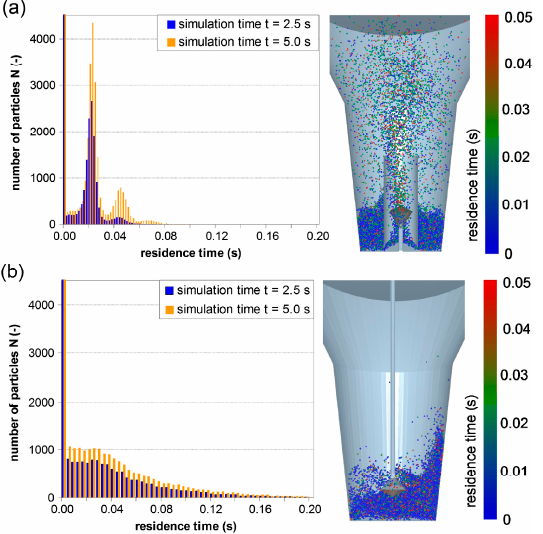
Figure 5. Residence time distribution of particles in the spray zone: ( a ) Wurster coater, ( b ) top spray granulator. Reproduced from reference [53] permitted by Elsevier.